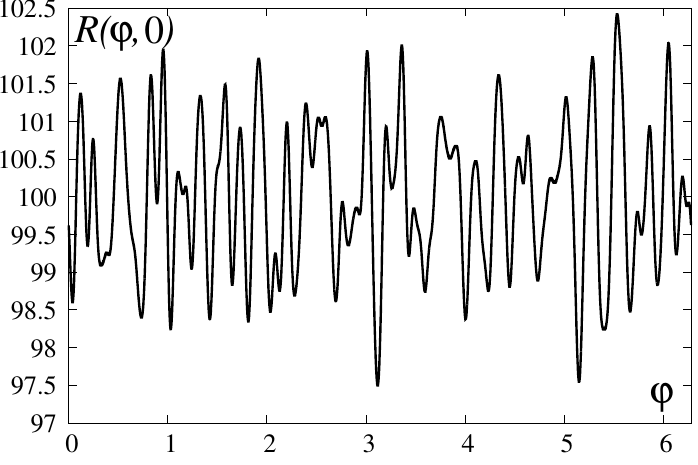
Figure 3. Initial condition R ( ϕ ,0 ) at A = 0.005, R 0 = 100, N = 2 15